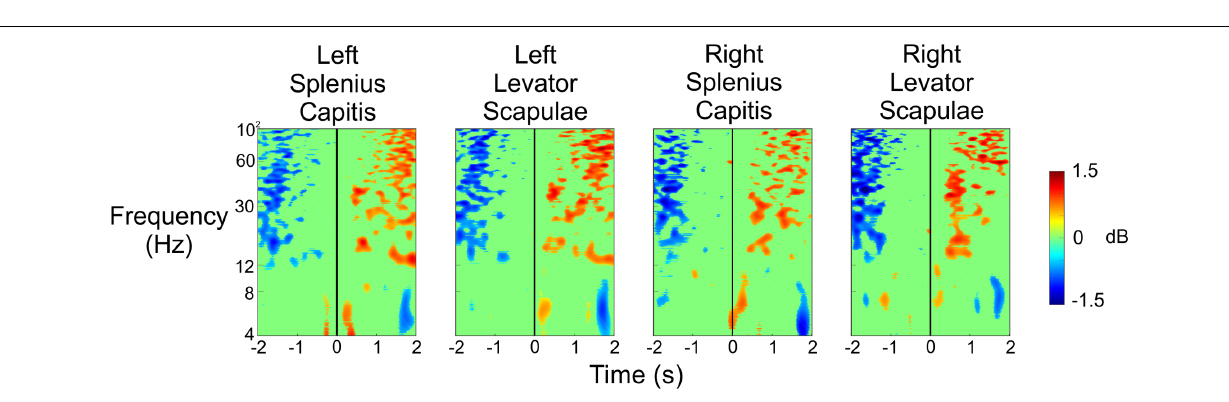
FIGURE 8 | Event-related spectral perturbation plots for the neck muscle activity during the Stress condition when the experimenter shot at the subject. The vertical black line indicates the time at which the experimenter fired a shot (including both hits and misses) at the